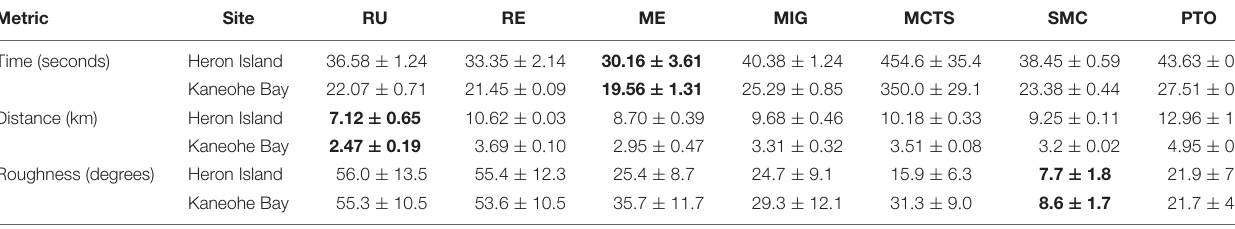
TABLE 3 | Associated costs for each sampling algorithm in terms of computation time, traversed distance, and smoothness. Metric Site RU RE ME MIG